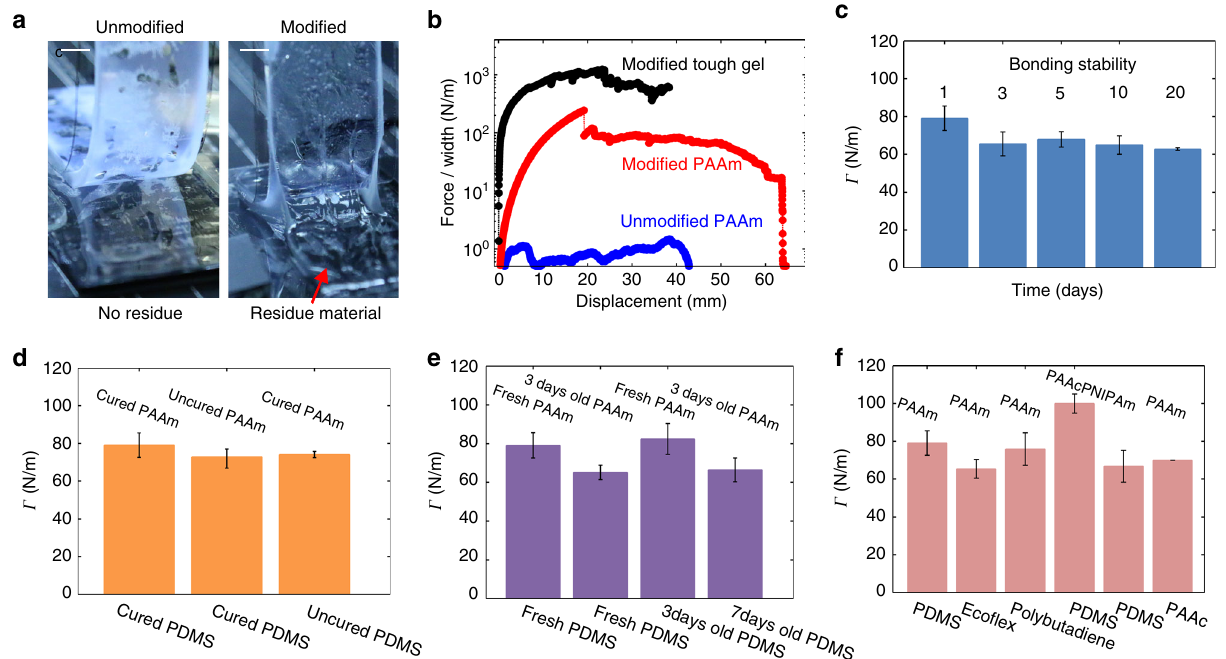
Fig. 2 Bonding hydrogels and elastomers. a For unmodi fi ed PAAm and PDMS, the hydrogel peels off on the interface and leaves no residue on the elastomer. For silane-modi fi ed PAAm and PDMS, fracture occurs in the hydrogel, leaving residue on the elastomer. The scale bar is 5 mm. b The force – displacement curves for a silane-modi fi ed PDMS substrate bonded with various forms of PAAm: unmodi fi ed PAAm (blue), silane-modi fi ed PAAm (red), and silane-modi fi ed PAAm toughened by an interpenetrating polyacrylate network (black). c The adhesion energy drops slightly over the fi rst few days as the coupling agents condensate, but stabilizes afterwards ( n = 3 – 5). d Bonding is achieved for various sequences of forming the networks ( n = 3 – 5). e Bonding is achieved even if the silane-modi fi ed samples are a few days old before contact ( n = 5). f Bonding is achieved for various hydrogels